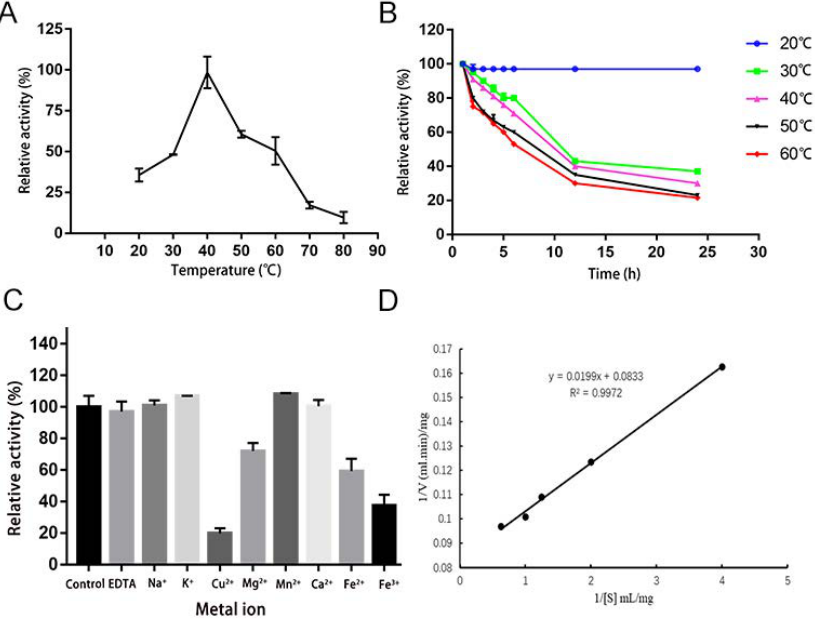
Figure 1. Characterization of SeCar: ( A ) determination of optimum temperature; ( B ) determination of thermotolerance; ( C ) effects of metal ions and chemical reagents on SeCar activity; ( D ) kinetic parameters of